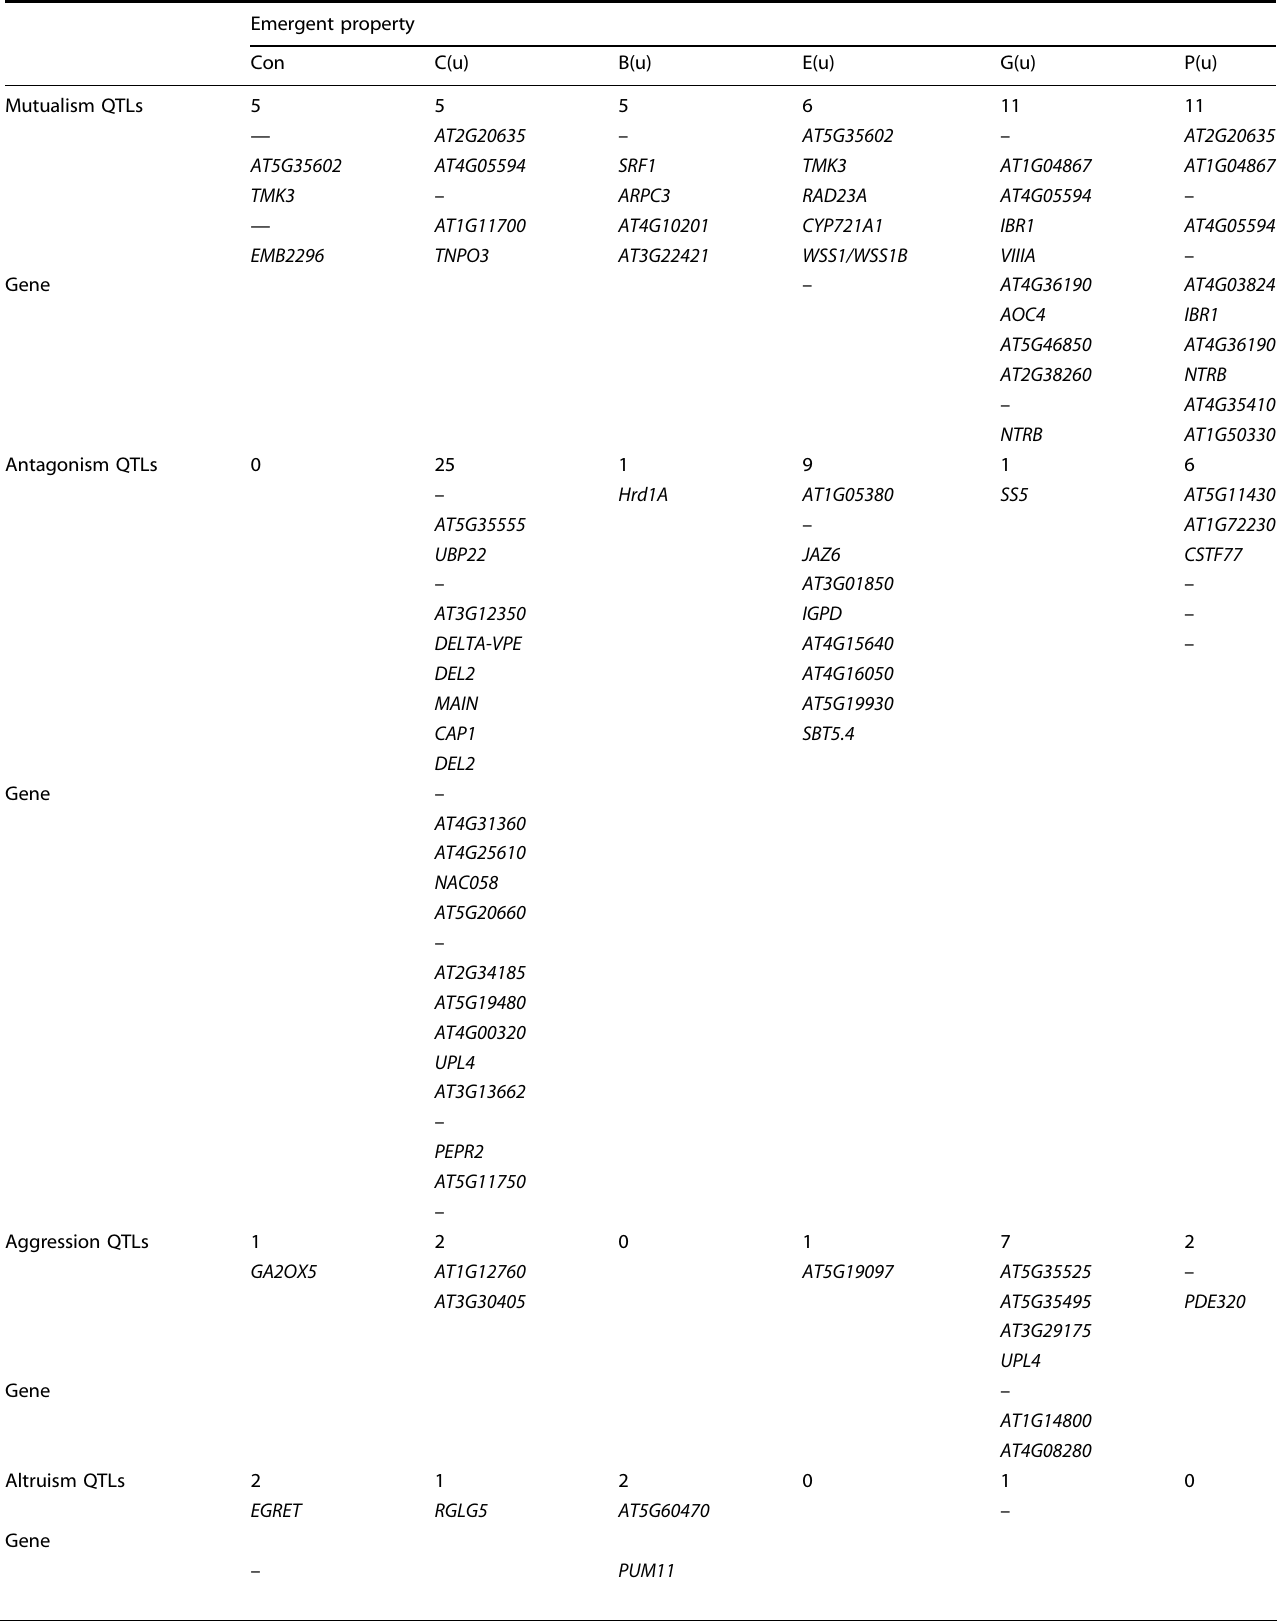
Table 1. Numbers of mutualism, antagonism, aggression, and altruism QTLs that affect the emergent properties of ecological networks. The names of genes to which QTLs are annotated are given